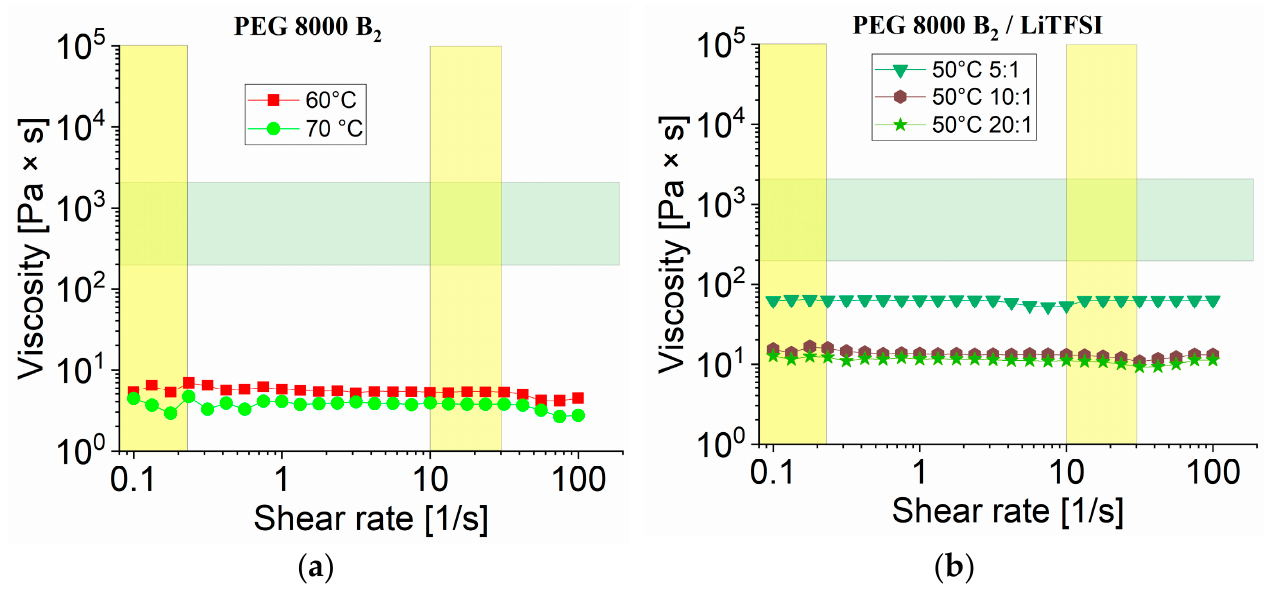
Figure 6. Rheology measurements viscosity vs. shear rate for ( a ) PEG 8000 B 2 at 60 °C and 70 °C; ( b ) PEG 8000 B 2 mixed with LiTFSI (EO/Li 5:1 ( 8 ), 10:1 ( 9 ), 20:1 ( 10 )) at 50 °C;.